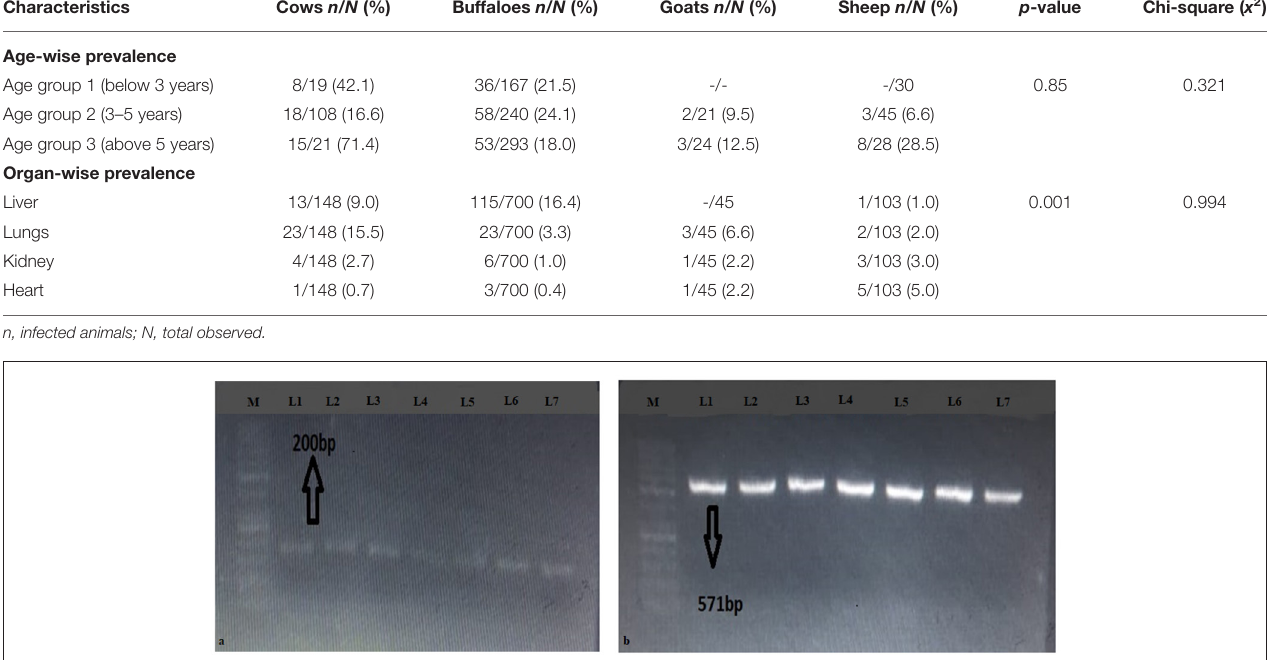
TABLE 3 | Prevalence of cystic echinococcosis in different age groups of organs of livestock. Characteristics